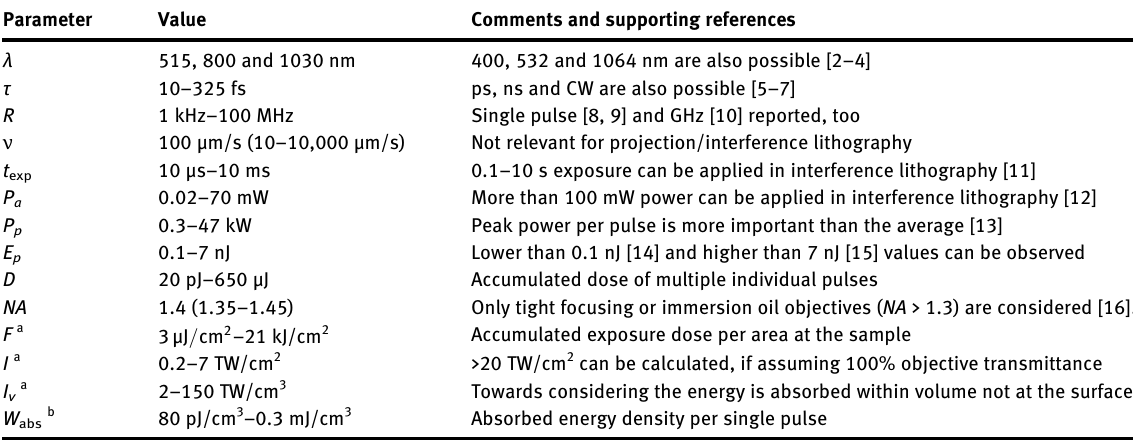
Table  : Studied parameters and their typical used values [ 